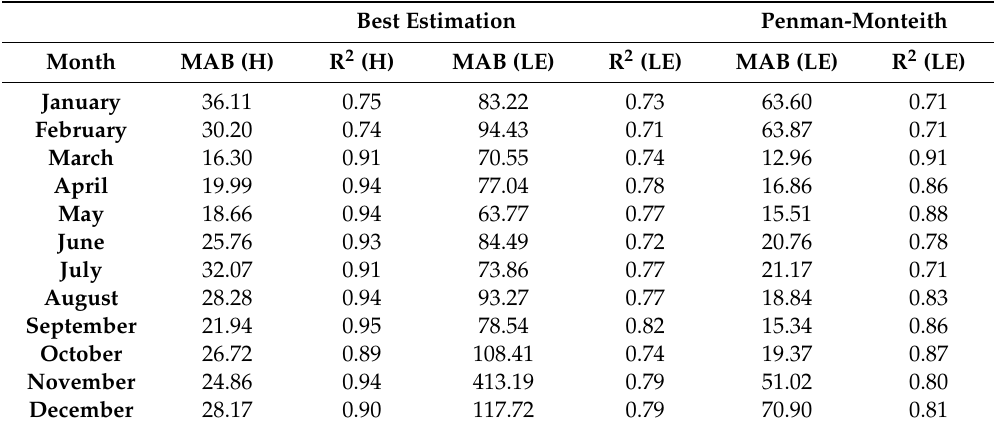
Table 2. Monthly values for the mean absolute bias (MAB is in W m − 2 ) and R 2 when applying the best possible estimation and the Penman-Monteith method. Best Estimation